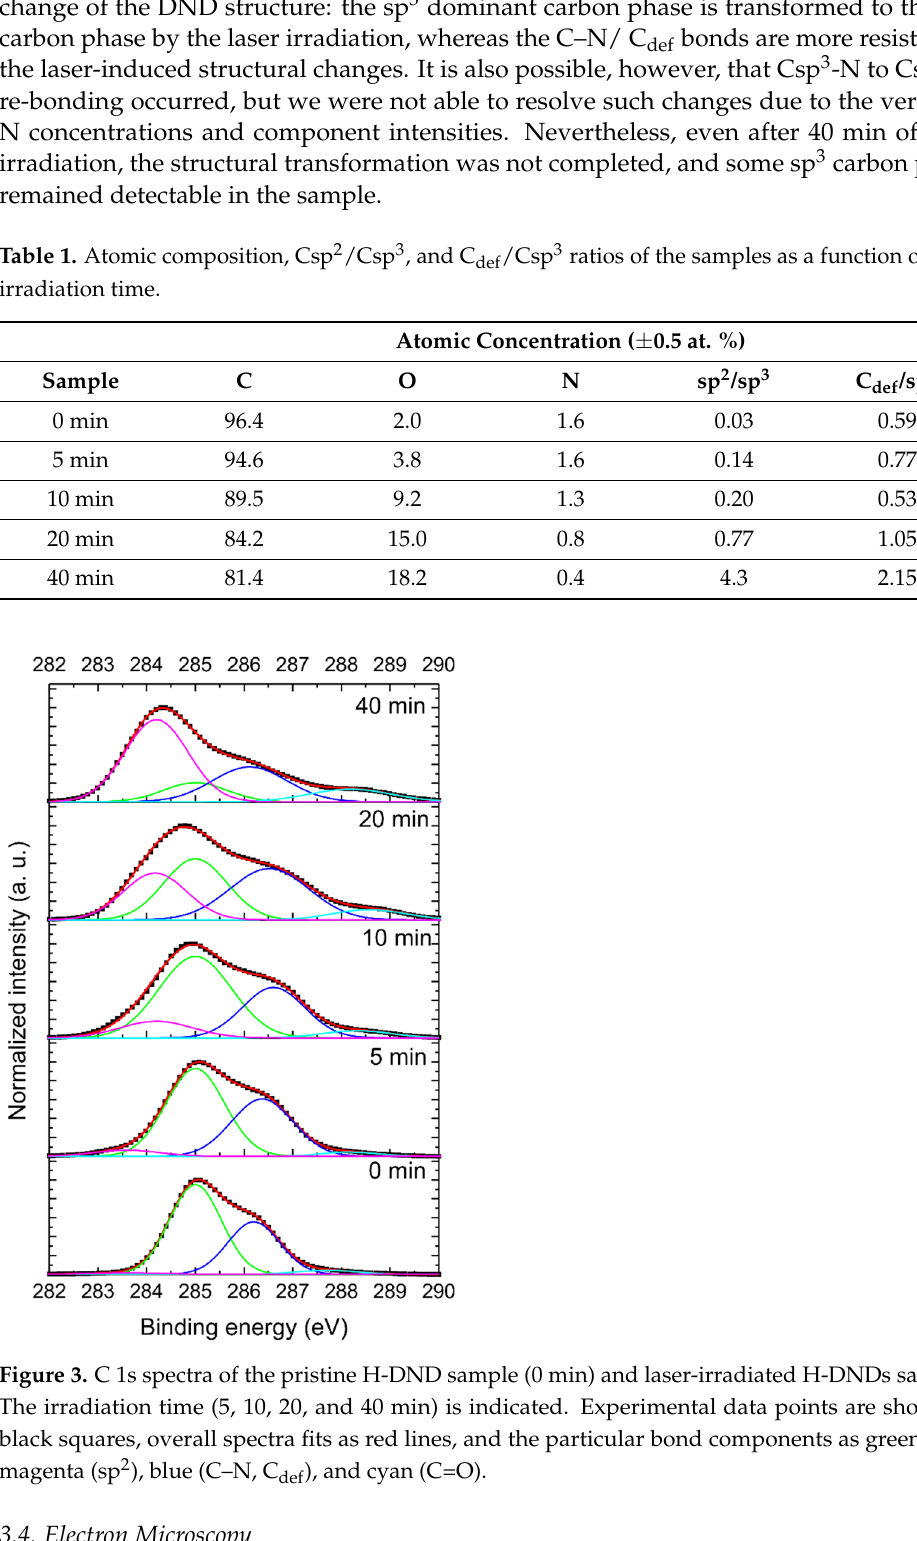
Table 1. Atomic composition, Csp 2 /Csp 3 , and C def /Csp 3 ratios of the samples as a function of laser irradiation time.